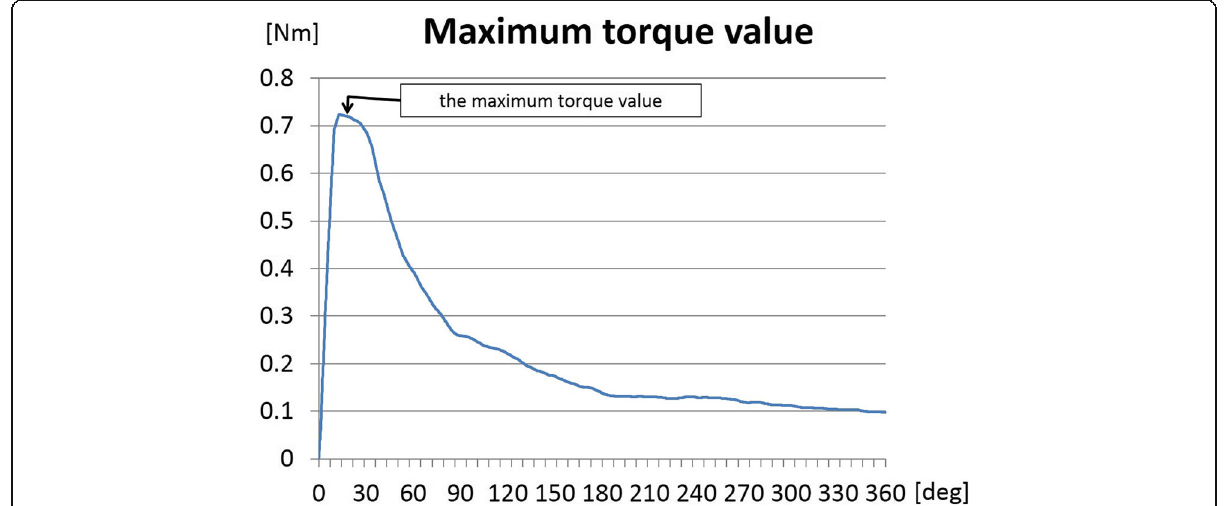
Fig. 2 Maximum torque value. The torque value was measured continuously. The torque value reached the maximum at the moment when the screw began to rotate, and the value at that time was defined as the maximum torque value